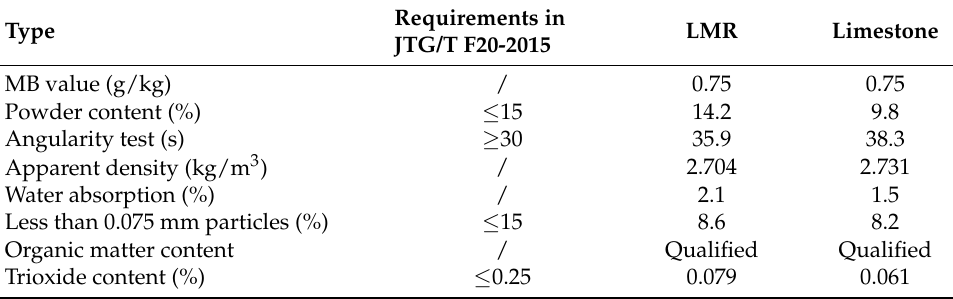
Table 5. The physical properties of LMR fine Table 4. The physical properties of LMR coarse aggregate.